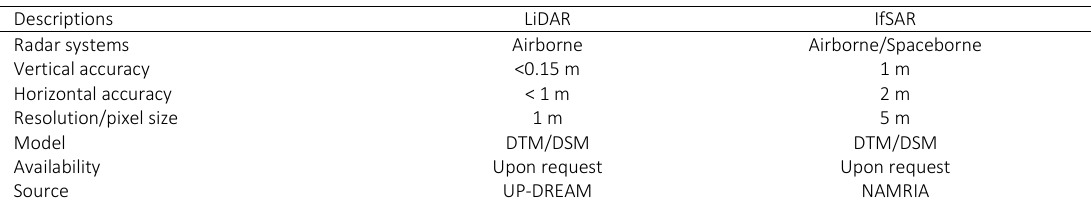
Table 1: Comparison of the two digital elevation models